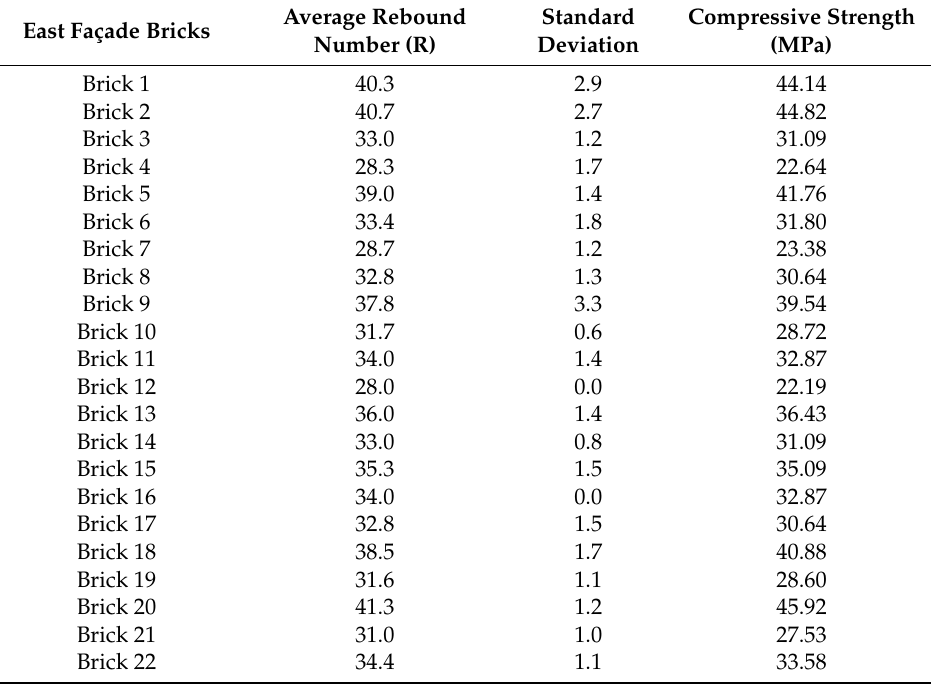
Table 4. Rebound hammer test results for the brick elements of the cloisonn é .